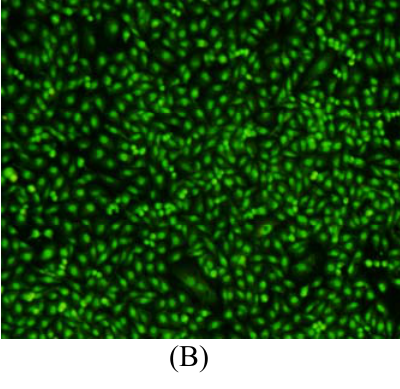
Figure 3. Photos of acridine orange staining (A: compound 10 , B: